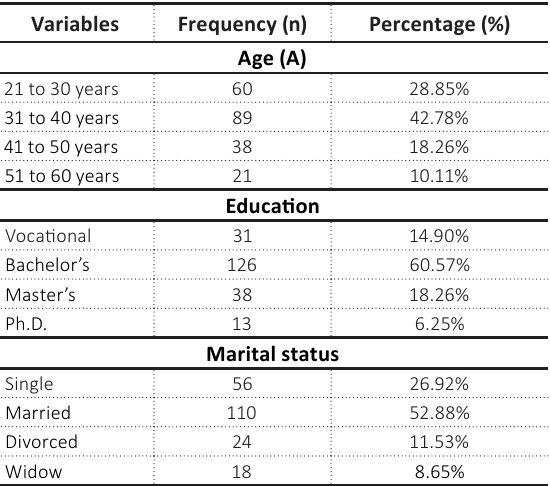
Table 1. Demographic profile of respondents Source: Primary data